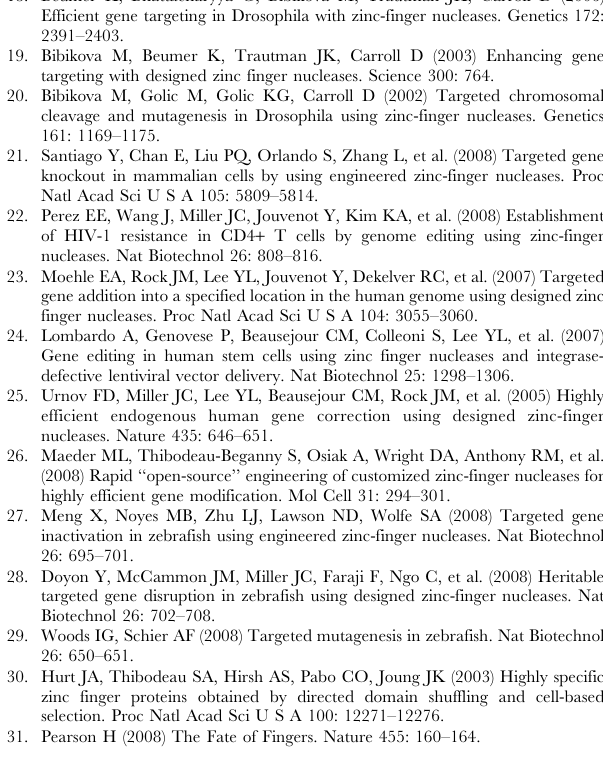
Table S20 Potential OPEN ZFN target sites in gene transcripts encoded on zebrafish chromosome 20. Data presented as described in the legend to Table S1.